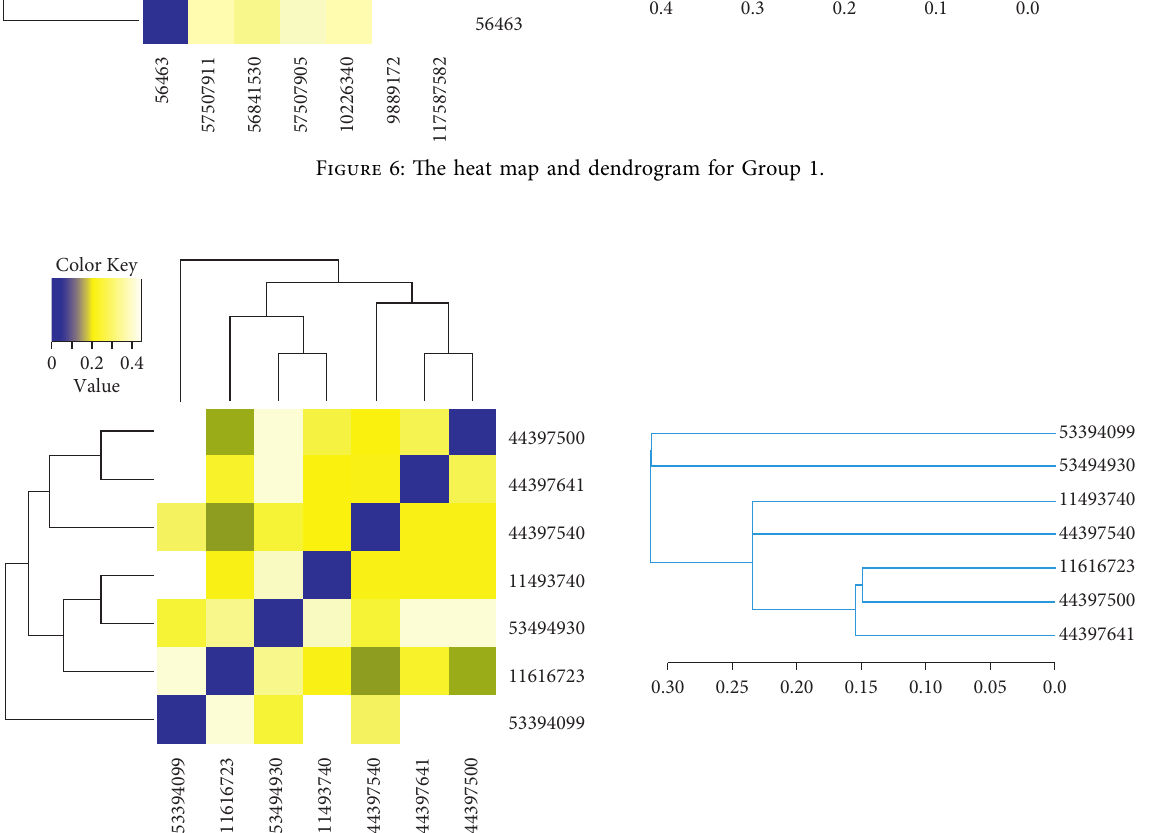
Figure 7: The heat map and dendrogram for Group 2.